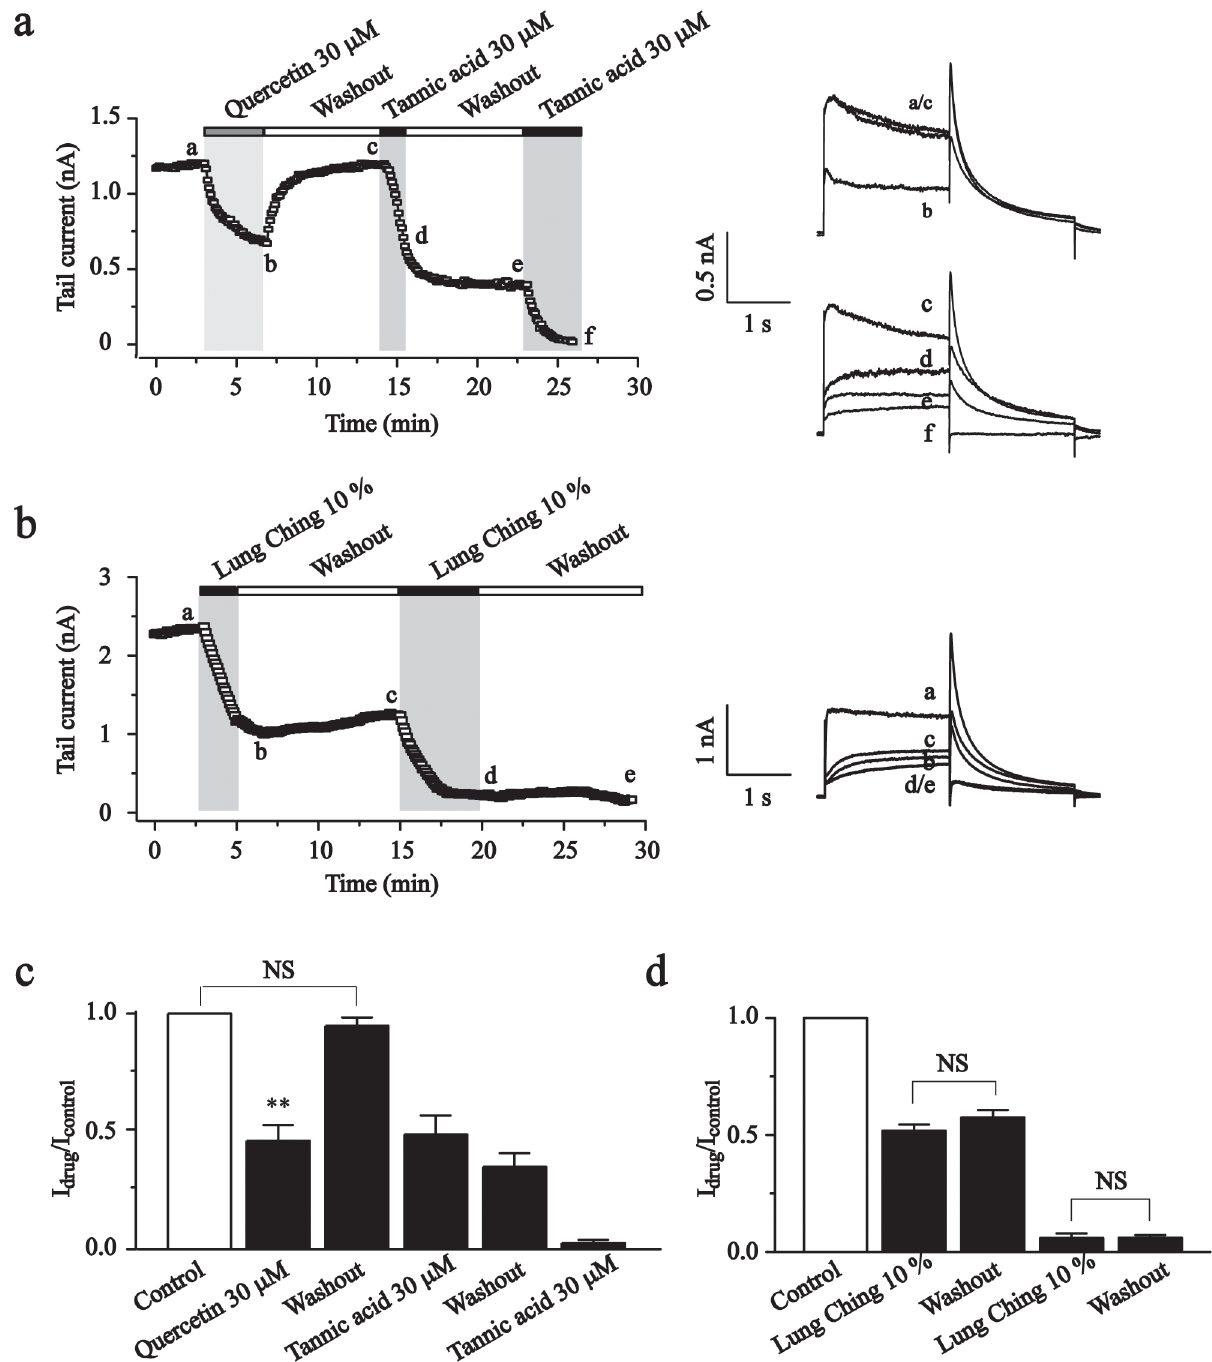
Fig 5. Tannic acid plays the key role in Lung Ching-induced hERG current inhibition. (a) The time courses for the effects of quercetin (30 μ M), tannic acid (30 μ M) and washout on the hERG currents recorded at -60 mV. The right panel showed the current traces recorded at the times indicated by the letters. (b) The time courses for the effects of Lung Ching (10%) and washout on the hERG currents recorded at -60 mV. The right panel showed the current traces recorded at the times indicated by the letters. (c) Summary for the effect of quercetin (30 μ M), tannic acid (30 μ M) and washout on the hERG currents. (d) Summary for the effect of Lung Ching (10%) and washout on the hERG currents. ** P < 0.01, NS, no significant.